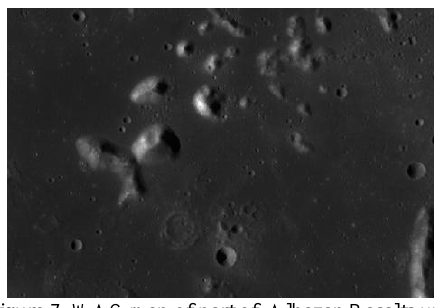
Figure 7. WAC map of part of Alhazan Basalts